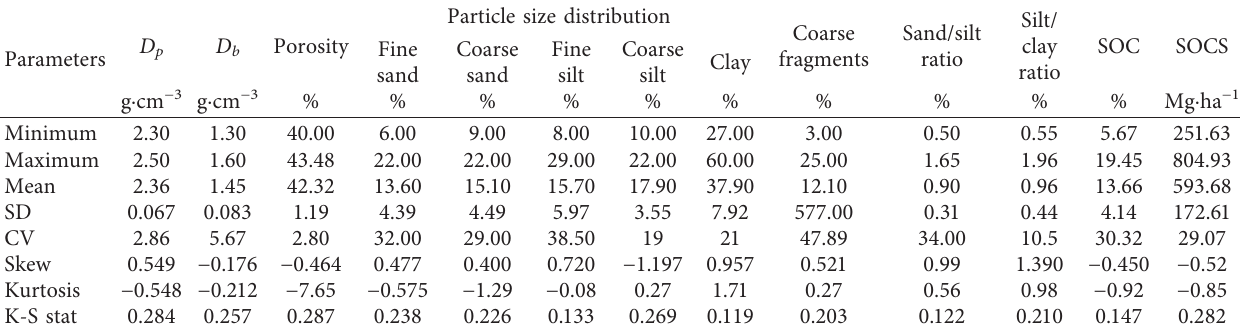
Table 2: Summary statistics of the soil physical characteristics and organic matter content ( n � 20). Particle size distribution D p D b Porosity Parameters